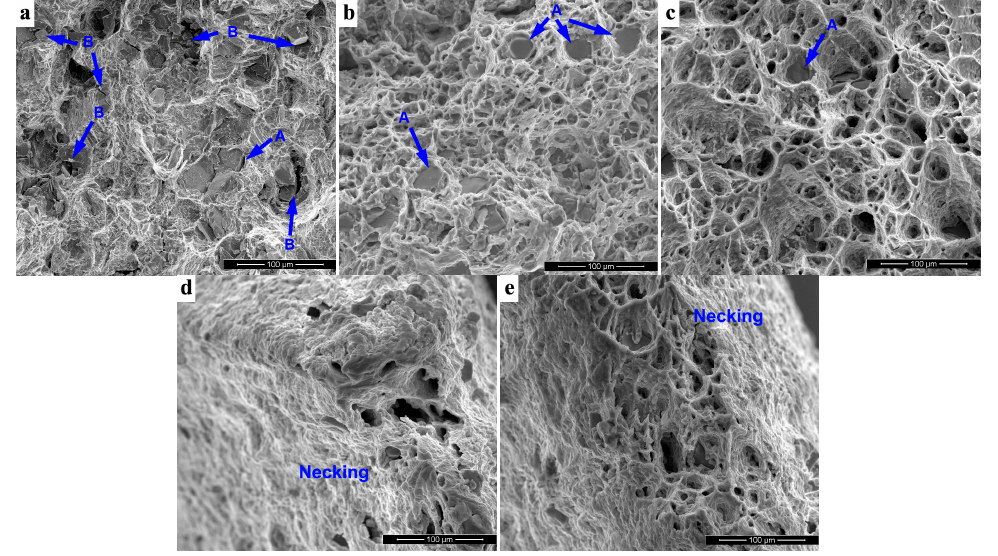
Figure 3. Fracture surfaces of the thixoforged composite tensile tested at different temperatures: ( a ) 25 °C; ( b ) 150 °C; ( c ) 200 °C; ( d ) 250 °C; ( e ) 300 °C.